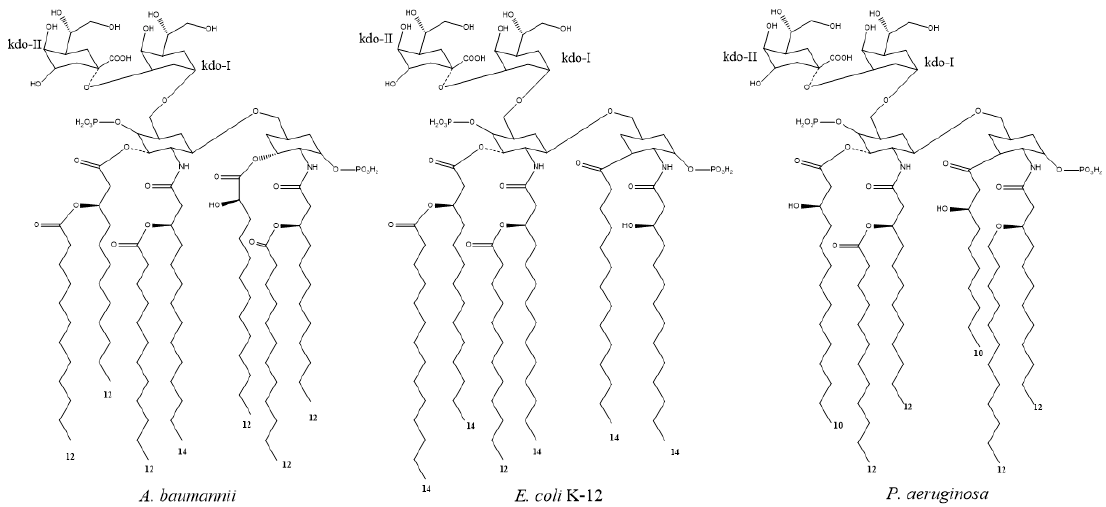
Figure 2. Lipid A structure of ( A ) A. Baumannii , ( B ) E. coli , and ( C ) K. pneumonia. E. coli and K. pneumonia primarily contain hexa-acetylated Lipid A, while A. baumannii share much similarity but lipid A is primarily hepta-acetylated. P. aeruginosa differs from the other Gram-negative species in that, its hexa-acetylated Lipid A had a different distribution of Acyl chains and the acyl chains were generally shorter. Numbers below acyl chains indicated the length of the carbon chain. Figures are adapted from Raetz [37], Boll [38], Li [39], and Kim [40].